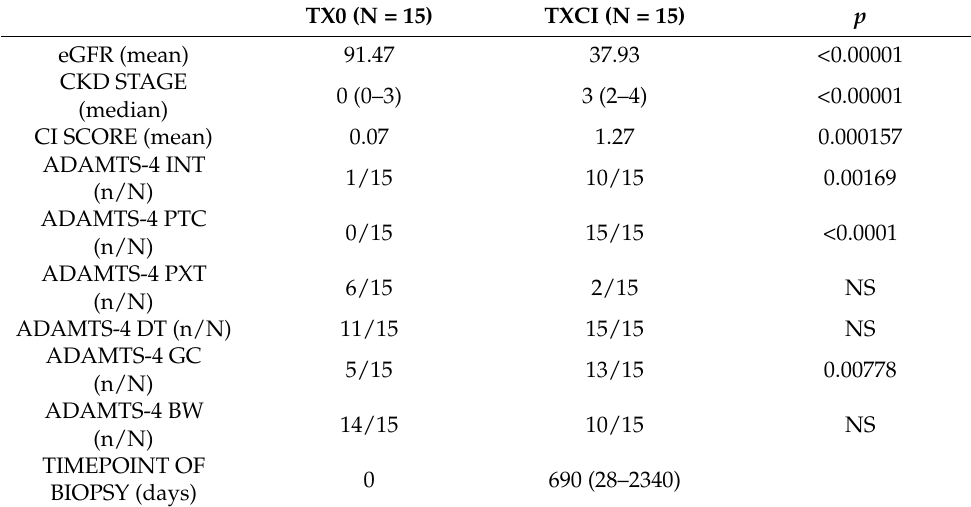
Table 2. Paired analysis of ADAMTS-4 expression between clinically indicated transplant biopsies (TXCI) and their belonging zero-time transplant biopsies (TX0)—15